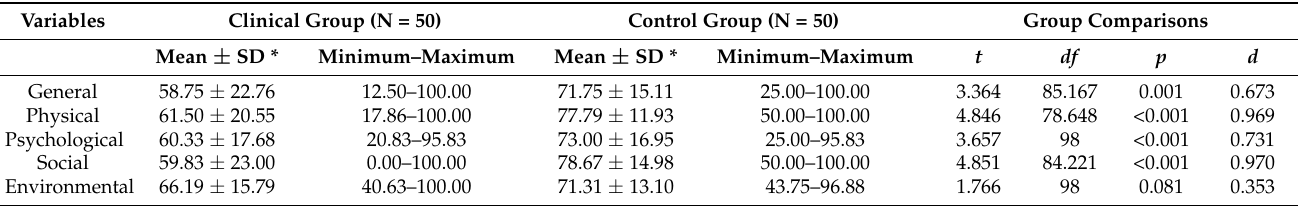
Table 2. Descriptive statistics for QoL domains (means, standard deviations, and range) and compar- ison of MS participants and healthy participants on QoL scores.